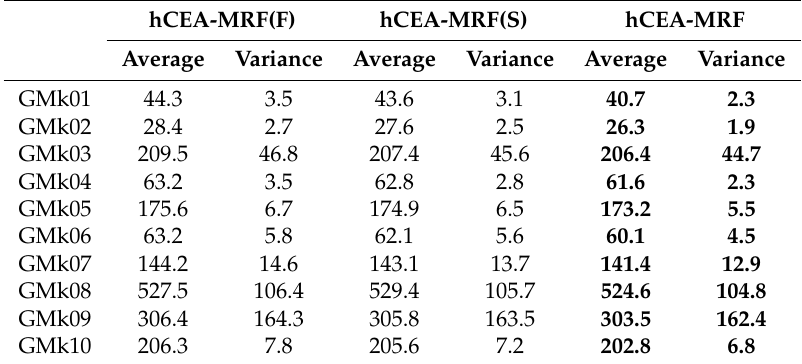
Table 11. The performance of different decomposition strategies for the generated instances by Gaussian distribution.